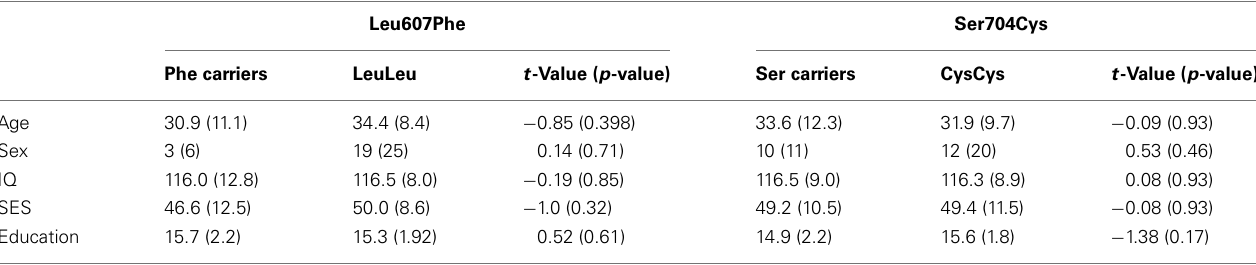
Table 1 | Summary of differences with respect to age, sex, IQ, socio-economic status (SES), and education based on Leu607Phe and Ser704Cys